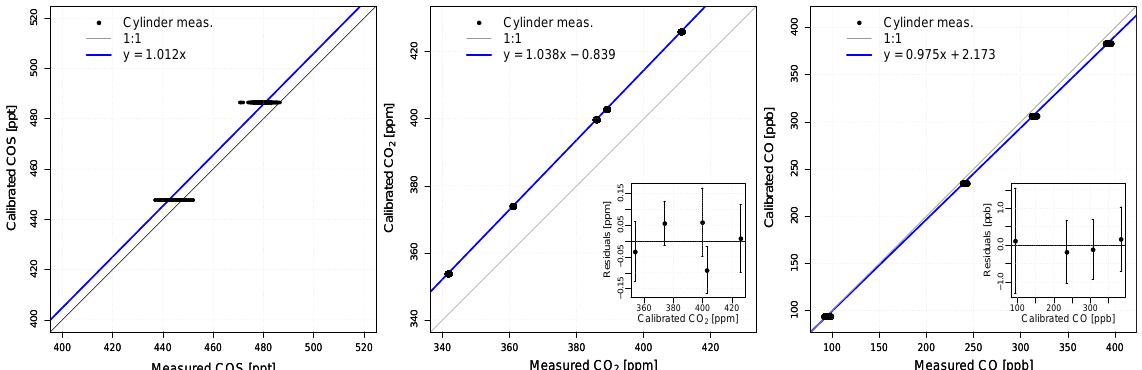
Figure 2. Response curves determined with NOAA/ESRL calibration standards, including the residuals of the fit. The NOAA/ESRL calibra- tion standards are calibrated on NOAA-2004 COS scale, WMO-X2007 CO 2 scale (Zhao et al., 2006) and WMO-2004 CO scale (Novelli et al., 2003). Each standard was measured for 5min. The measured mole fractions shown on the x axes are mole fractions calculated through the TDLWINTEL software but are corrected for drift using a reference standard. The drift was on the order of 8ppt for COS, 3ppm for CO 2 and 5ppb for CO and would have given biased results if this were not corrected